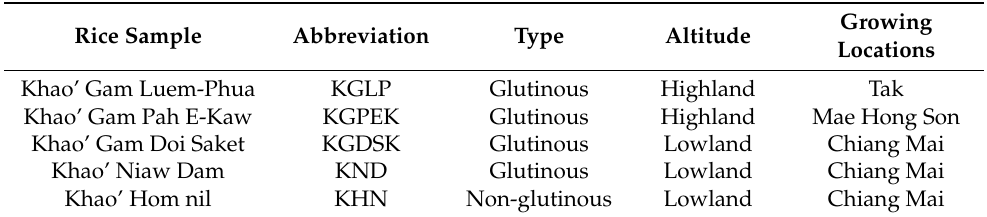
Table 5. Varieties, type, altitude, and growing location of rice